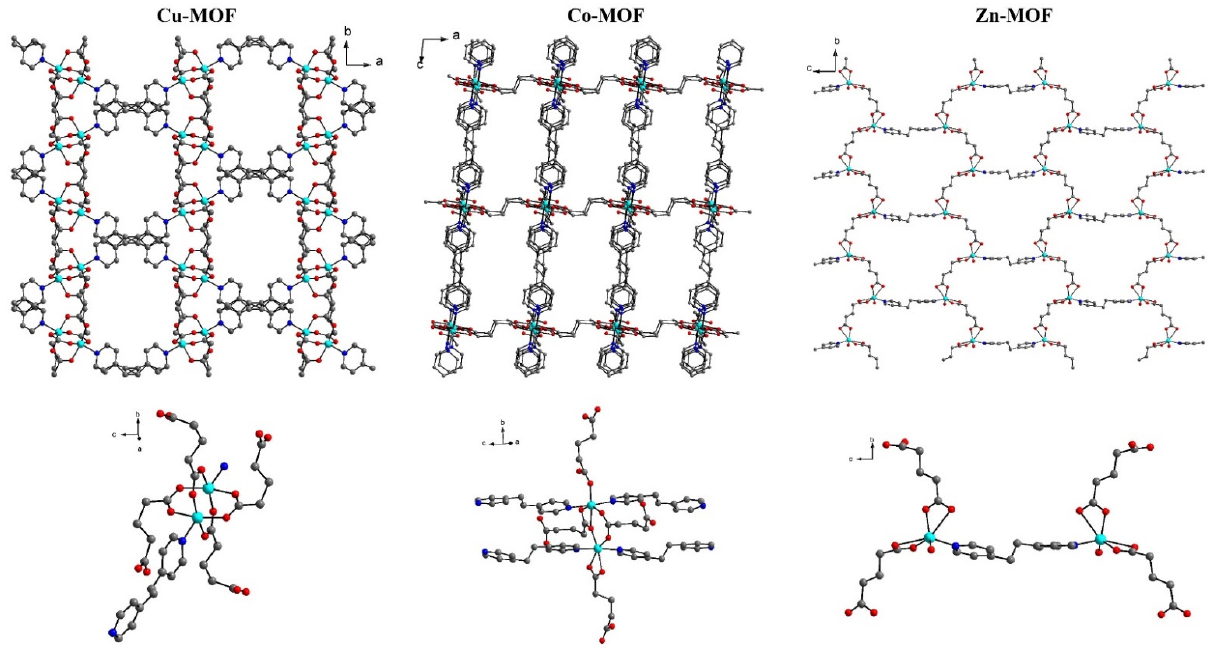
Figure 1. Crystal structures of the Cu-MOF, Co-MOF, and Zn-MOF along the b axis with a 2D sheet (upper) and coordination environment around metal (II) centers (Cu, Co, and Zn) (bottom). All hydrogens and disordered atoms are omitted for clarity. The color codes: green, metal (Cu, Co, and Zn); red, oxygen; blue, nitrogen; and grey, carbon.